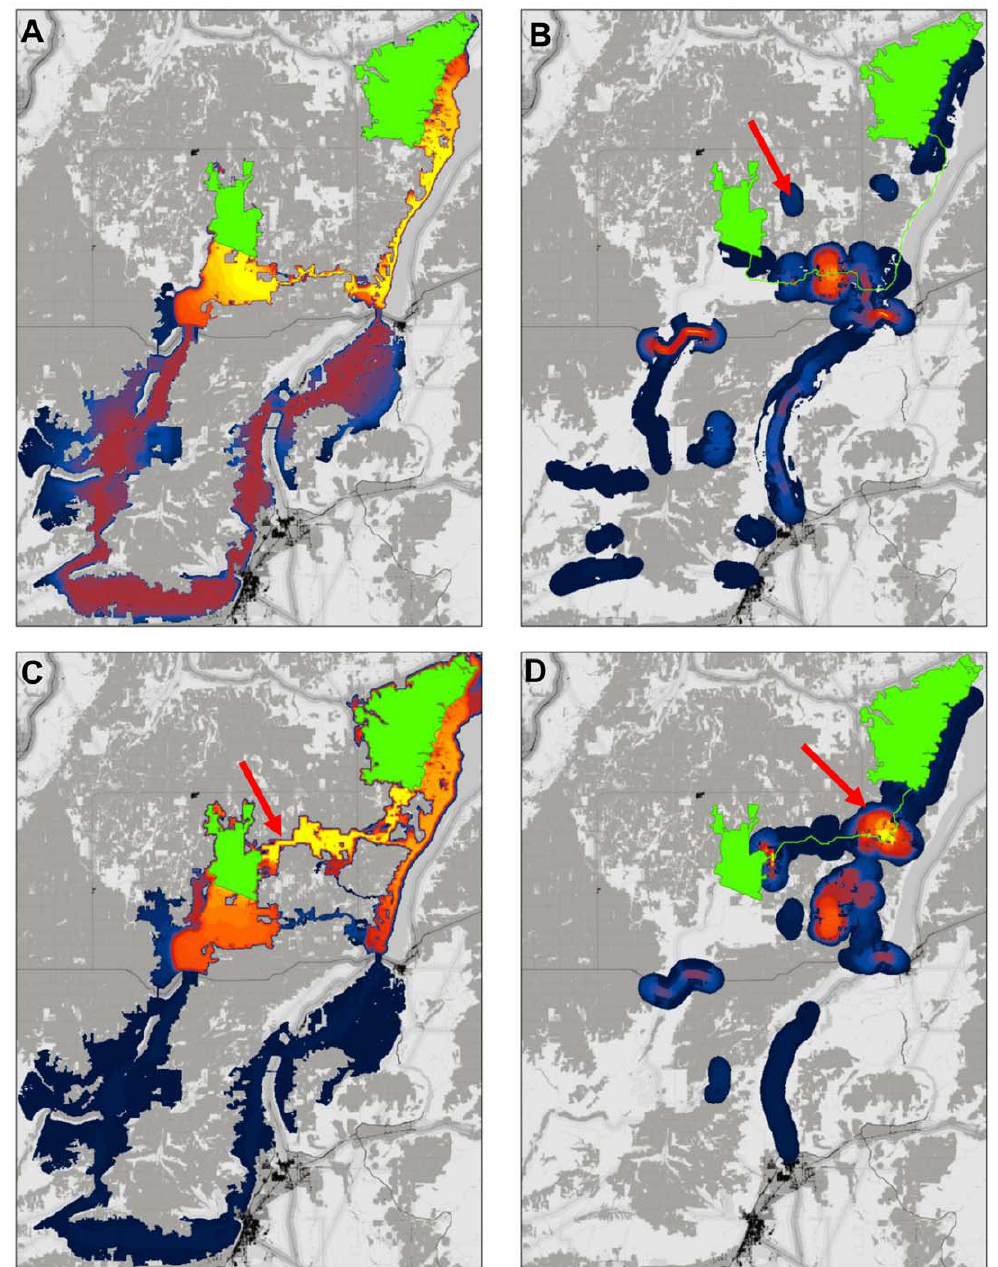
Figure 6. Reanalysis of connectivity modeling results using barrier detection algorithm. (A) Corridor connecting natural landscape blocks, showing least-cost movement routes. Best 20% of study area shown. (B) Barriers detected at diameters from 200 m to 2 km, with original least-cost path shown in green for reference. Mitigating barriers along the least-cost path (i.e., intersecting the green line) would improve the existing corridor without changing its location; mitigating barriers away from the path would re-route the best modeled corridor. (C) Restoring a 1 km 2 (500 m 6 2 km) swath spanning the barrier indicated by the arrow establishes a new least-cost corridor to the North. (D) A barrier analysis incorporating the simulated restoration indicates opportunities to substantially improve the new corridor with additional restorations.